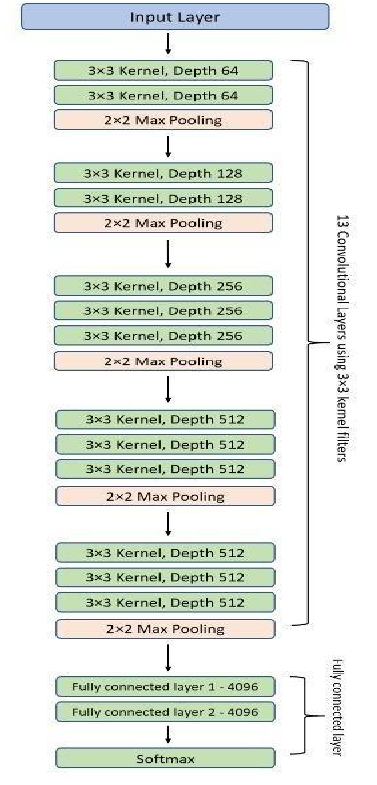
FIGURE I. VGG16 ARCHITECTURE.